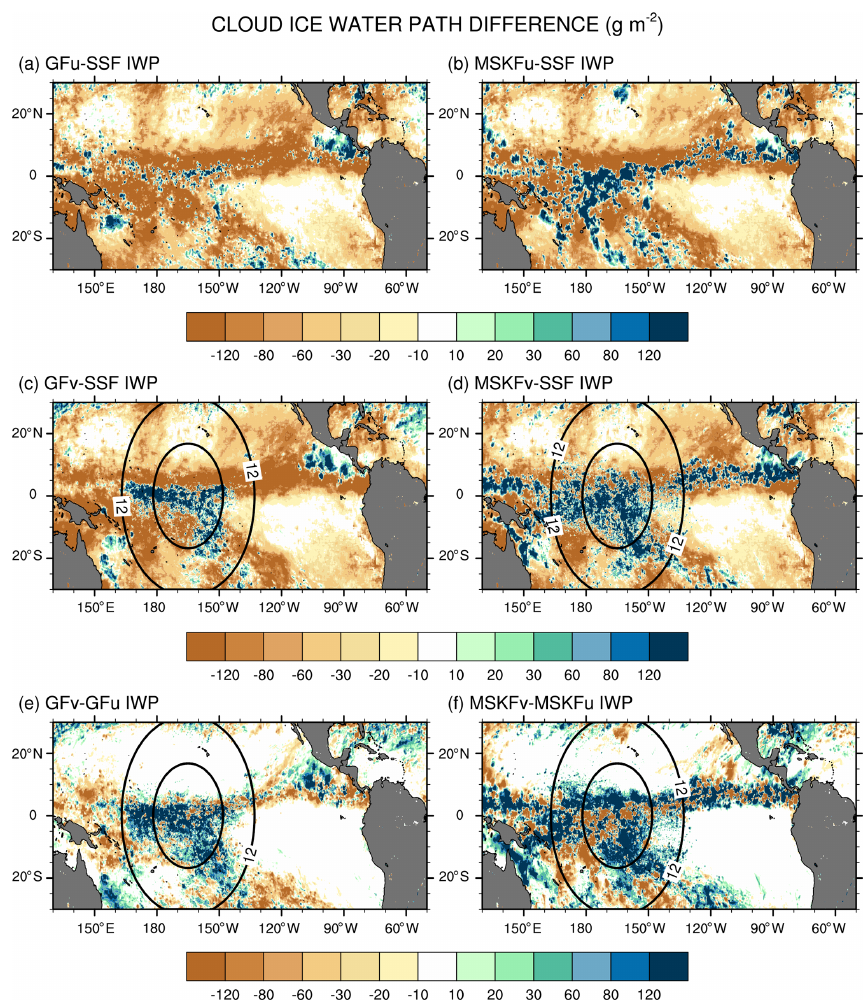
Figure 15. As Fig. 13 but for the cloud ice water path